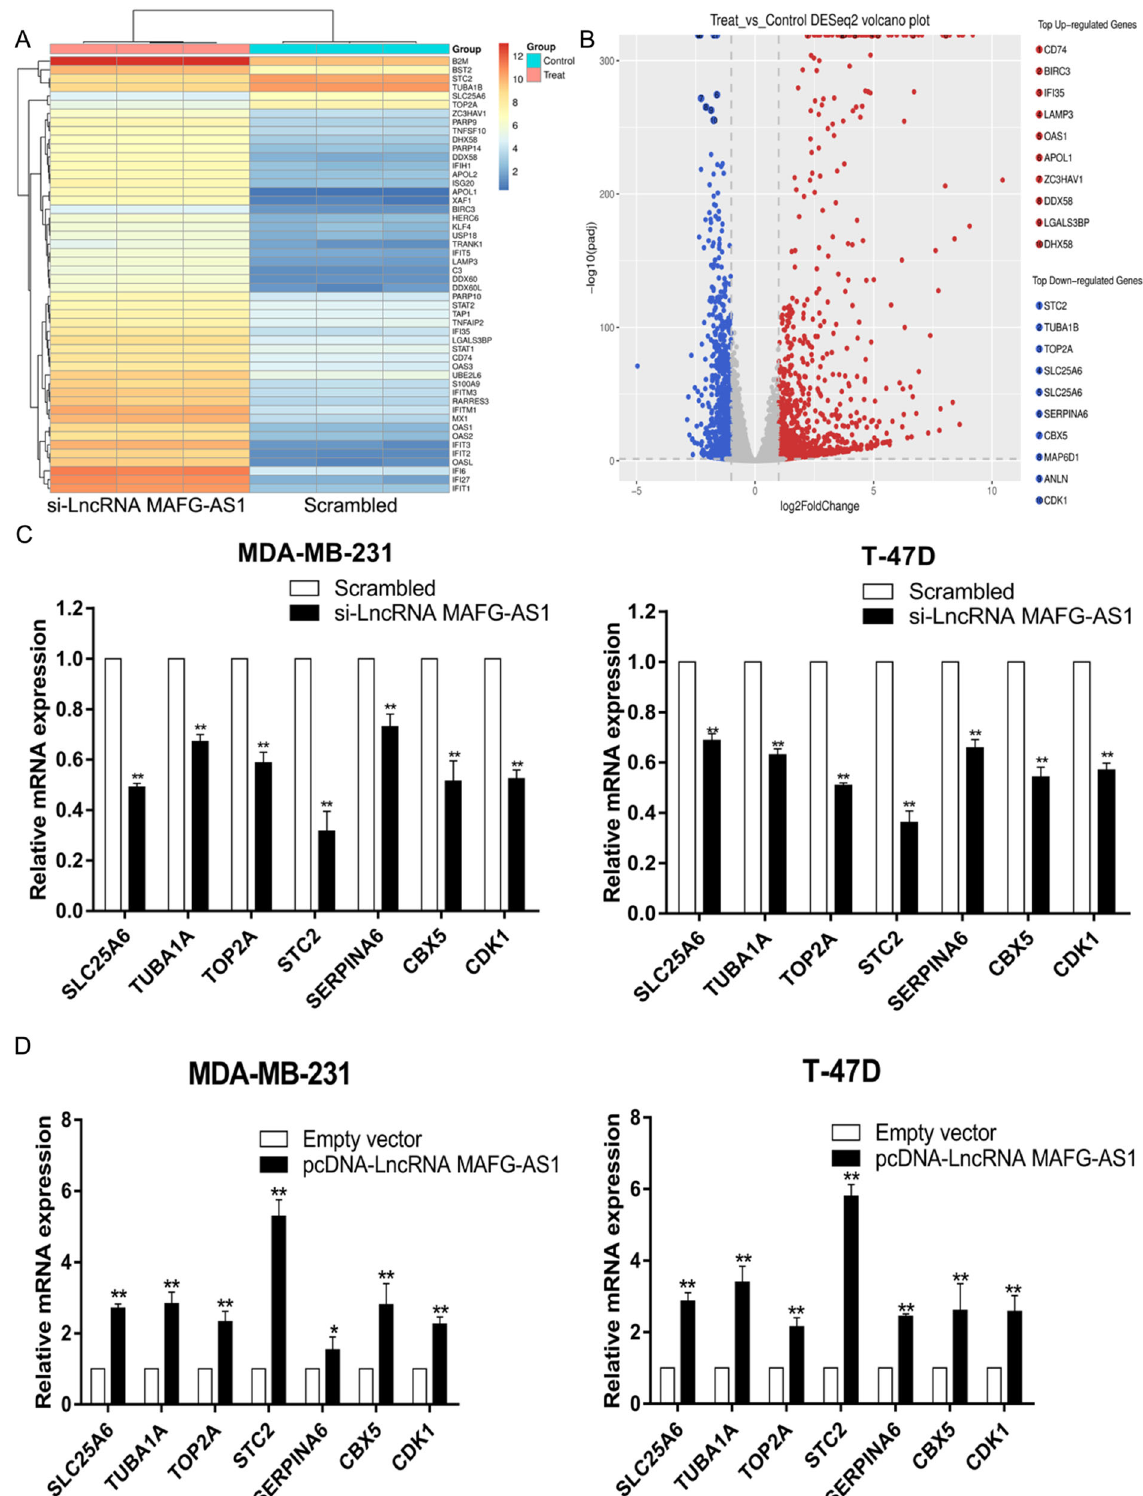
Fig. 6 STC2 is a downstream target gene regulated by LncRNA MAFG-AS1. A Mean centered, hierarchical clustering of transcripts altered in scrambled siRNA treated cells and si-LncRNA MAFG-AS1 treated cells, with three repeats. B The top ten of upregulation or downregulation genes after si-LncRNA MAFG-AS1 in T-47D cells. C , D qRT-PCR analysis in si-LncRNA MAFG-AS1 treated or pcDNA-LncRNA MAFG-AS1 treated BC cells showed altered mRNA level of genes involved in cell apoptosis and migration upon LncRNA MAFG-AS1 depletion. Values are shown as the mean ± s.d in three independent experiments. * P < 0.05, ** P < 0.01.